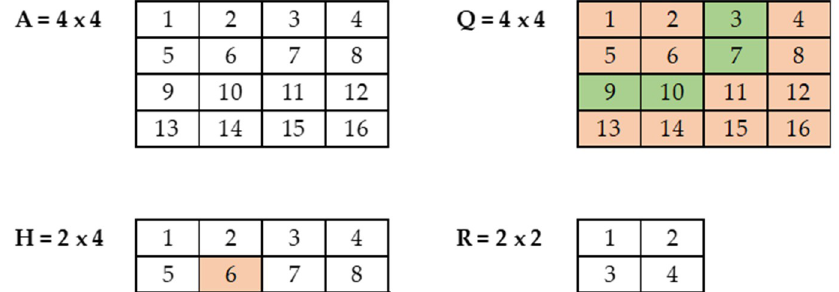
Figure 5. Summary results from likelihood ratio tests comparing the null and extended models. Parameters that were separated in the two mindset conditions are shown in red (0.05 ≤ p < 0.1), and green (0.01 ≤ p < 0.05). See Appendix B for the details of the test results.